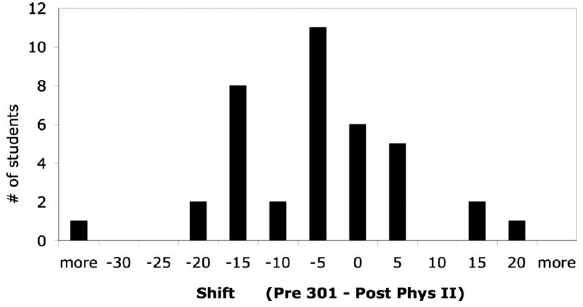
FIG. 4. Shift in BEMA scores between freshman (cid:1) post (cid:2) and junior (cid:1) pre (cid:2) . Histogram shows individual student shifts: (cid:1) student scores just before Phys 301 (cid:2) — (cid:1) Score from same student after Phys II (cid:2) . The average shift is −5 (cid:5) 2